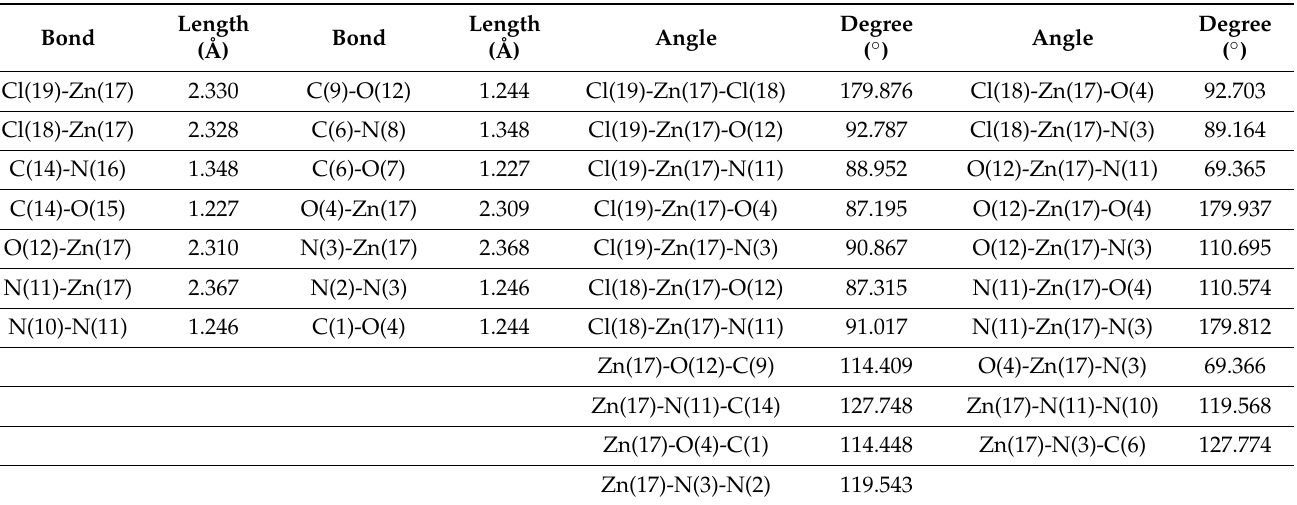
Table 9. Selected bond lengths (Å) and bond angles ( ◦ ) of (Zn complex) ligand using DFT-method from DMOL 3 calculations.